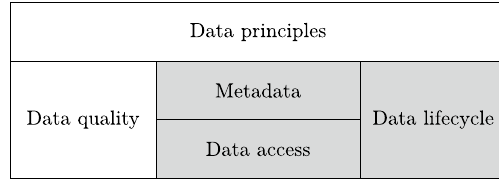
Fig. 1 The organization data assets from [4] (in gray those covered by this